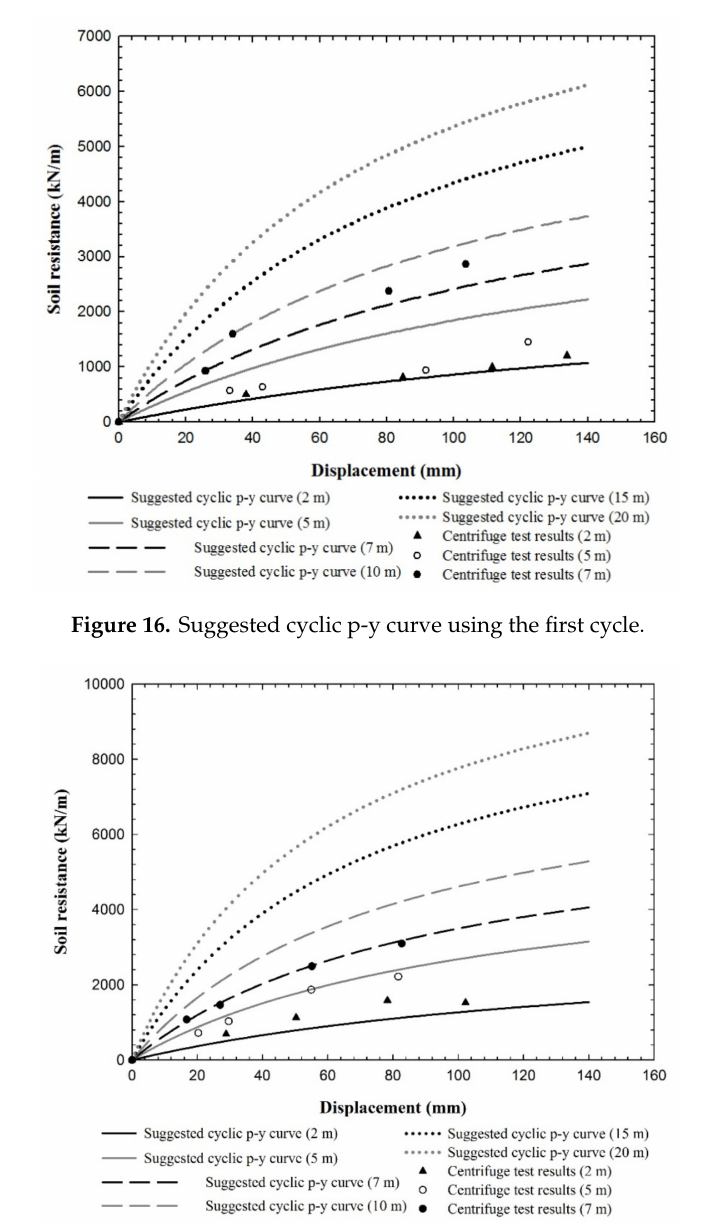
Figure 17. Suggested cyclic p-y curve using the 100th